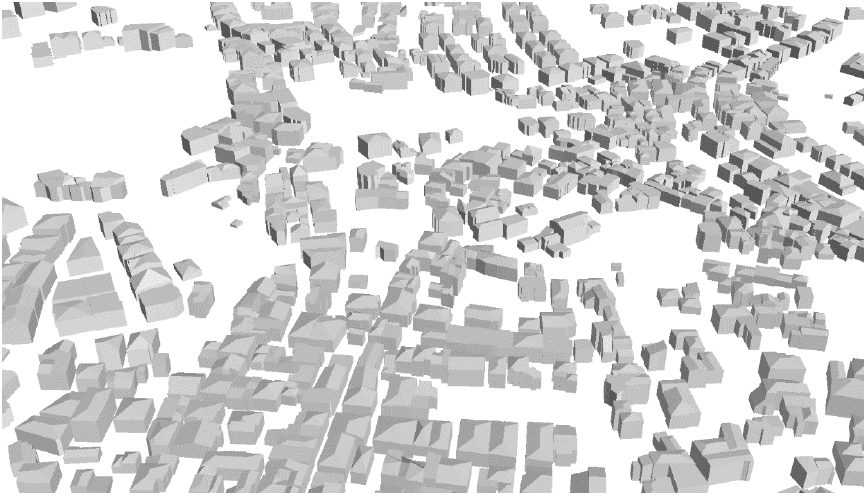
Figure 14. Automatically generated buildings with BuildingReconstruction 2018 software in Cesme Town.